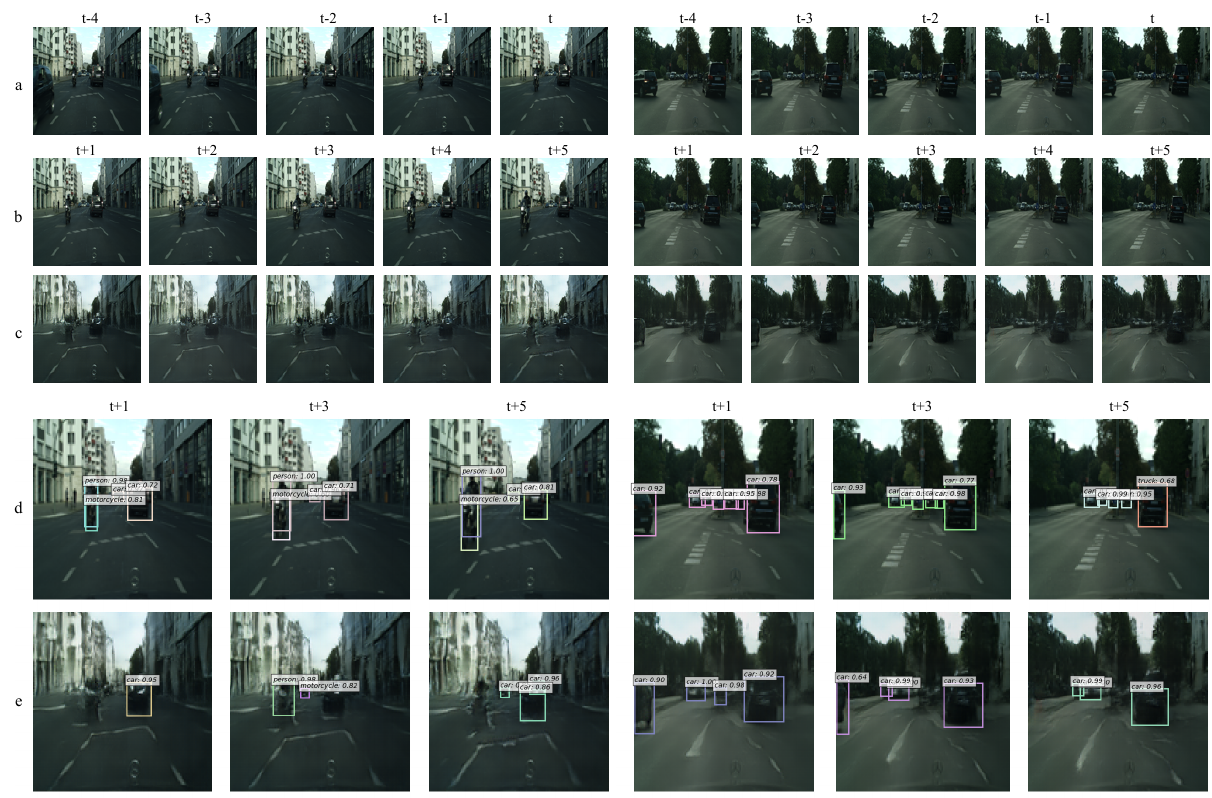
Figure 5. Prediction results for the KTH Action test split. a: Input, b: Ground Truth, c: FutureGAN (ours), d: fRNN, e: MCNet